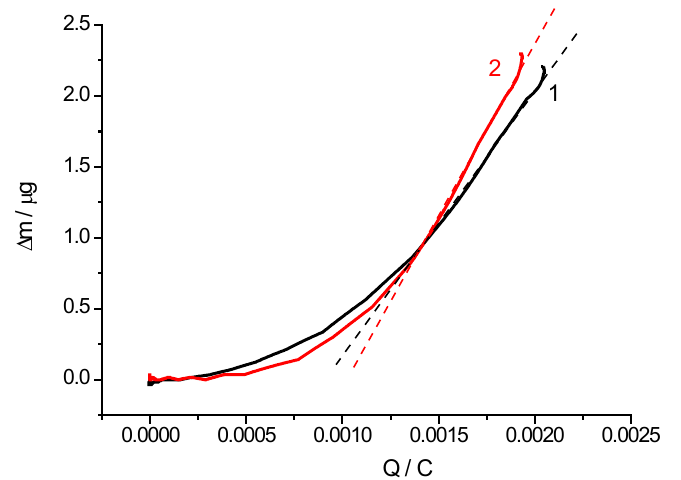
Figure 4. An oxidation mass-charge plot of a Pt-coated quartz crystal electrode (1.37 cm 2 ) modified with poly[NiSalphen] (black curve 1) or poly[NiSalphen(CH 3 O) 2 ] (red curve 2) at 0.05 V s −1 in 0.1 M Et 4 NBF 4 /PC.